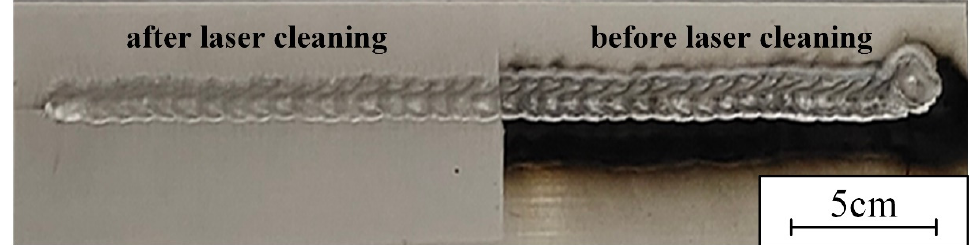
Figure 15. The weld formation before and after laser cleaning of black ash.